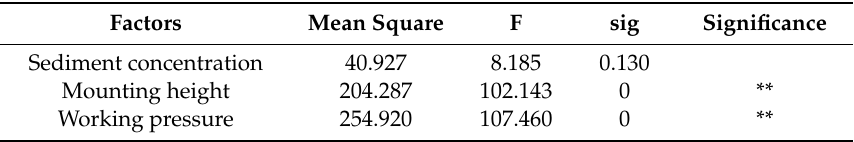
Table 3. Analysis of water diffusion results.